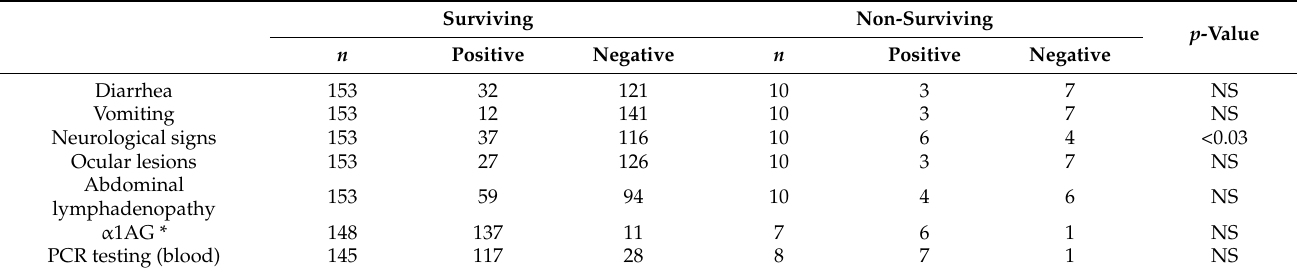
Table 6. Statistical comparison of categorical parameters between surviving and non-surviving cats with dry FIP.